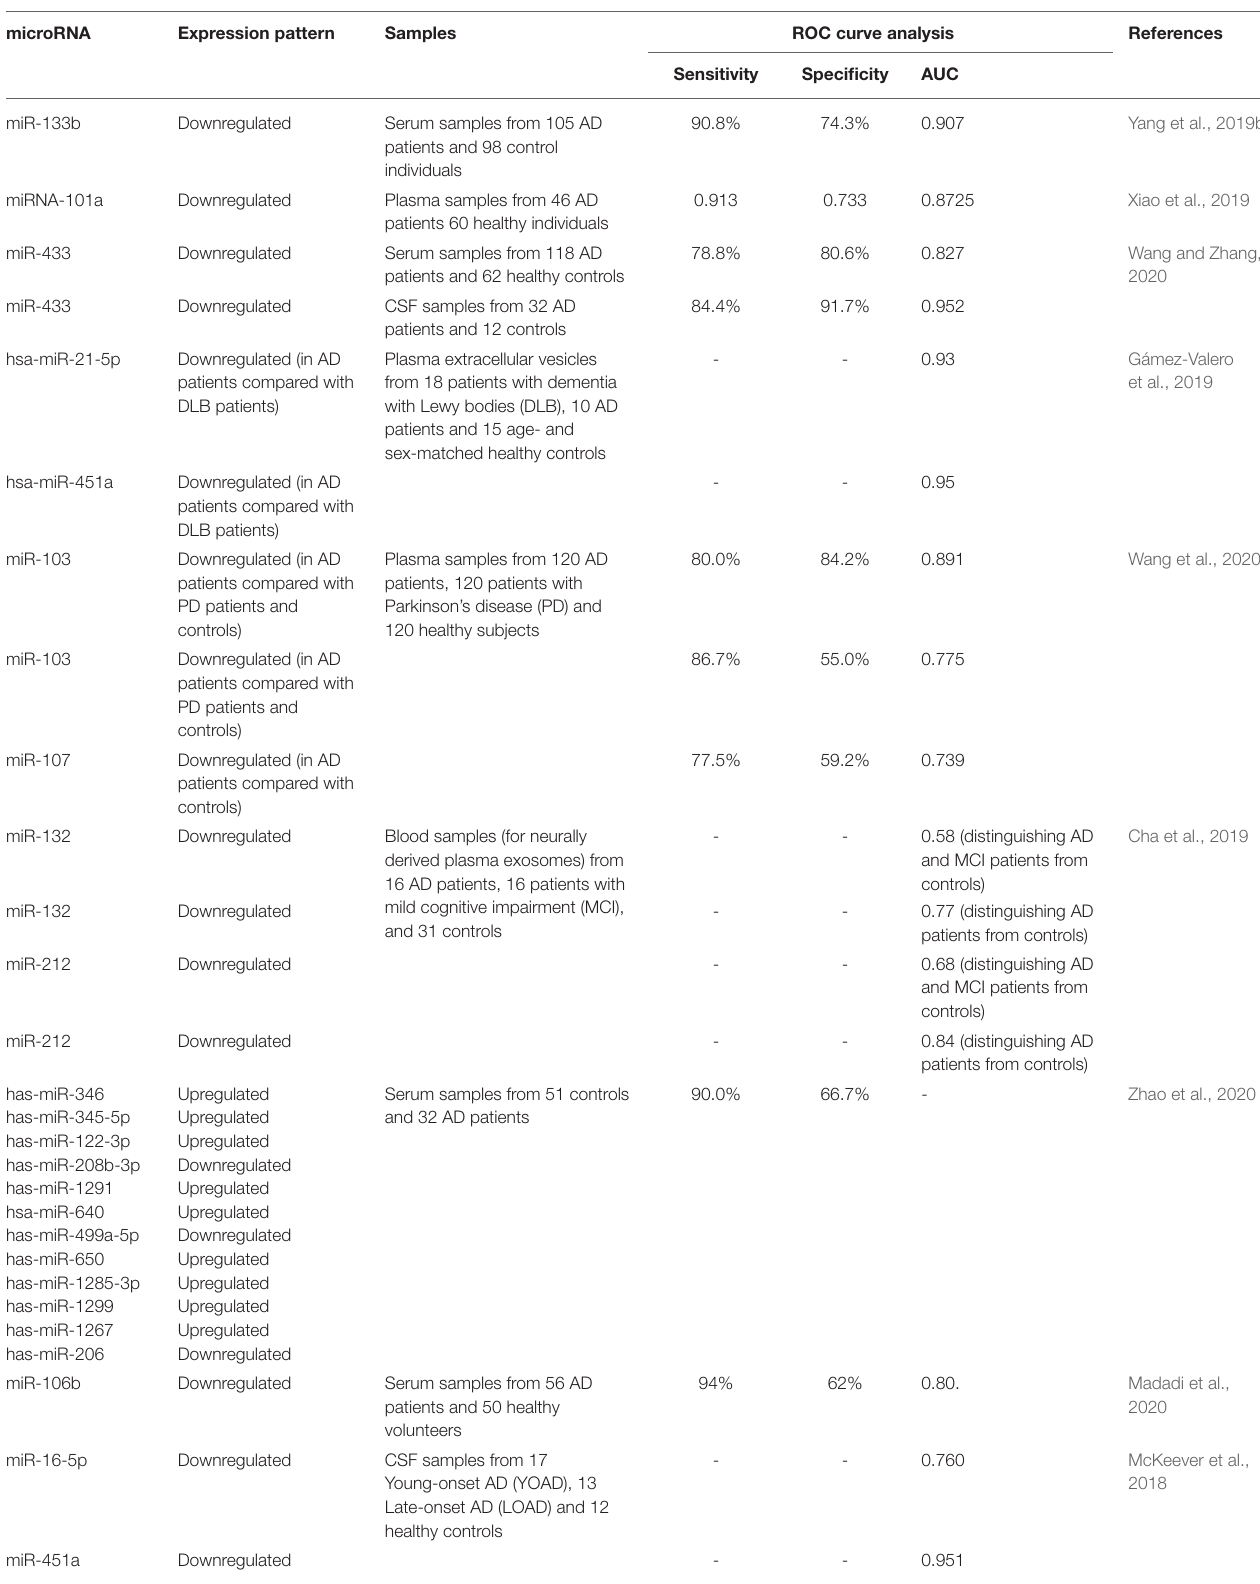
TABLE 3 | Diagnostic role of miRNAs in